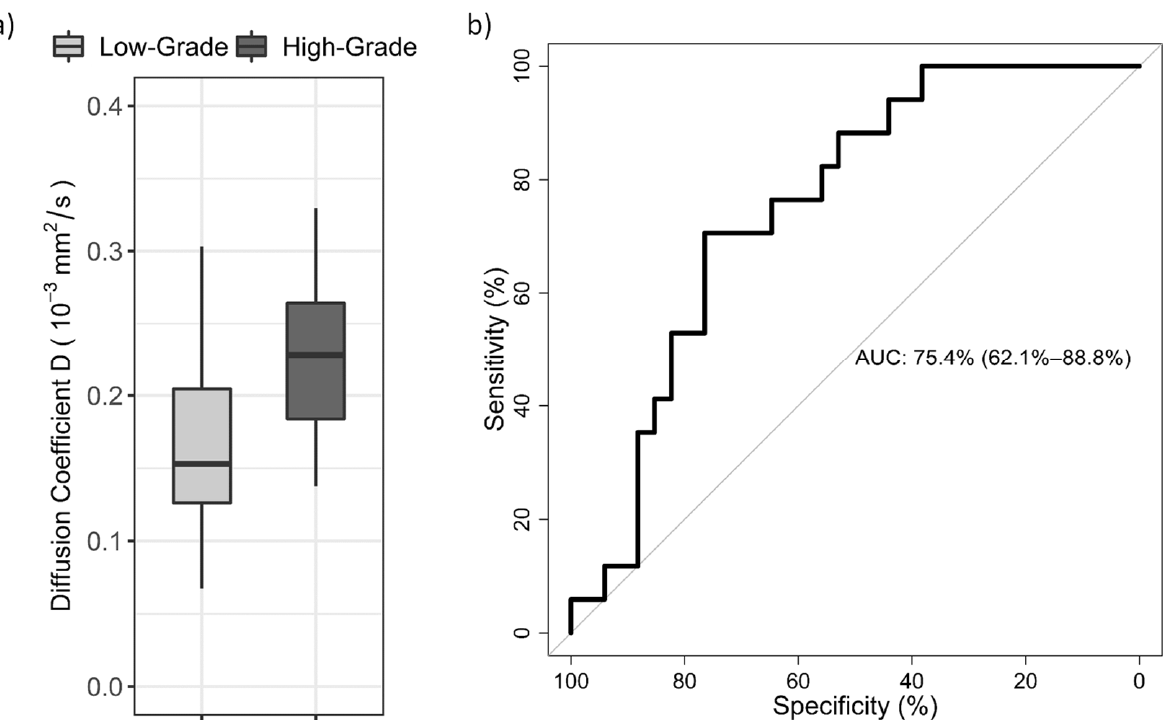
Figure 2. ( a ): Box-and-whisker plot shows the IQR D values for the two groups of endometrial cancer patients. Significant difference was found for D values between the low-grade and high-grade group ( p < 0.05). ( b ): Receiver operator characteristic (ROC) curve for tumor grade diagnosis in endometrial cancer patients using the interquartile range (IQR) of the whole-tumor D histogram. AUC: area under the curve.